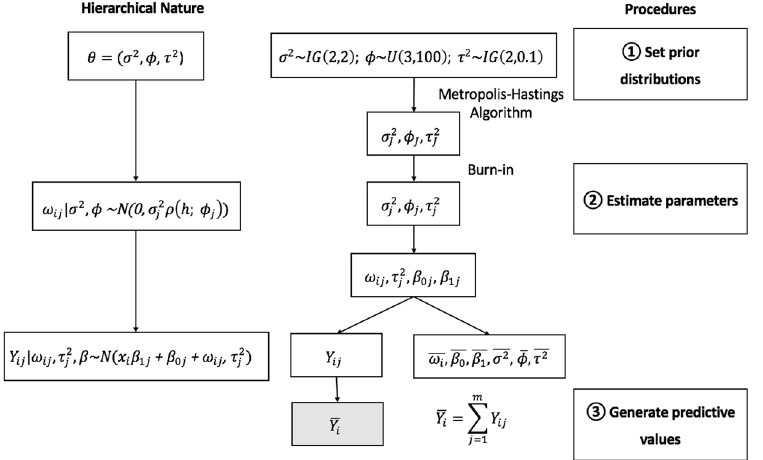
Figure 2. Hierarchical nature and procedures involved in constructing the daily Gaussian processes models. = ... i n 1 , is the location index ( n differs in each daily model); the iterations have indices = ... J 1, , 5,000 ; after the burn-in period, only the iterations after 3,000 (including 3,000) are retained, so = ... j 1 , 2001 . ω β β σ , 2 , and φ τ , 2 are the daily mean values of each parameter. Other symbols have the same definitions as given